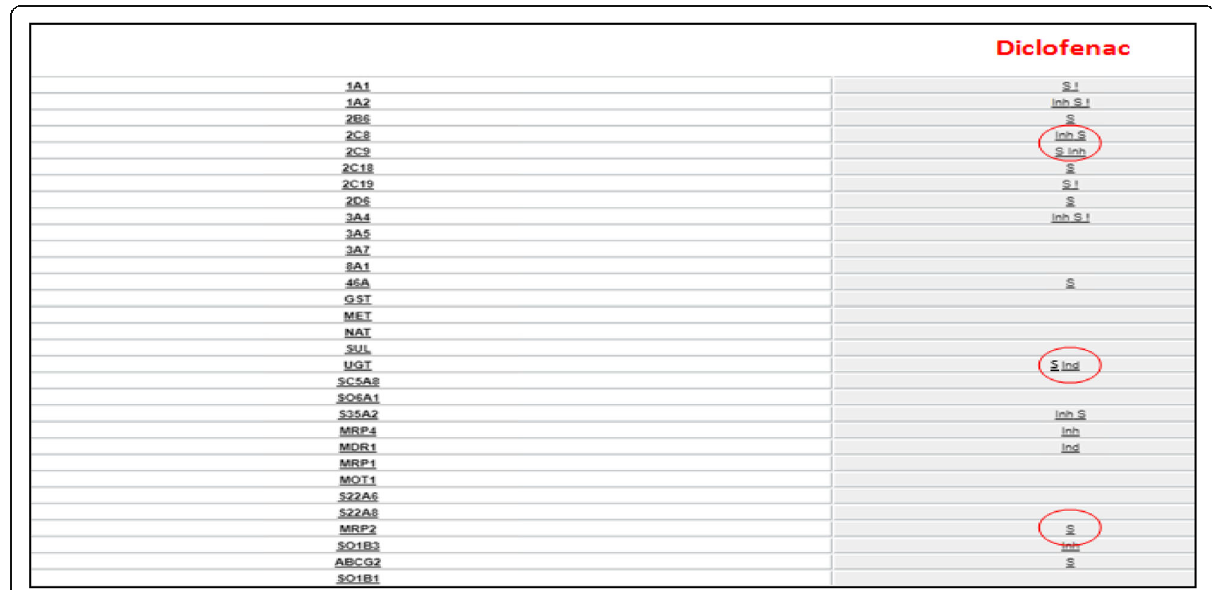
Fig. 1 Diclofenac metabolic profile. In the left column there is the list of drug metabolizing enzymes and drug transporters, one for each row; in the right column relationship between corresponding transporter or enzyme of the row and diclofenac: is indicated by the symbol ‘ S ’ for substrate, ‘ Inh ’ for inhibitor and ‘ Ind ’ for inducer. Enzymes CYP 2C9, CYP2C8 and UGT and transporter MRP2 (ABCC2) are rimmed to emphasize their importance in diclofenac ’ s metabolic destiny. Related page at the website http://bioinformatics.charite.de/transformer